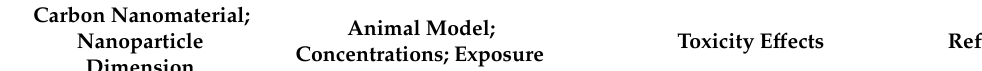
Table 2. The in Vivo Toxicity E ff ects of 0-D and 1-D Carbon Nanomaterials. Carbon